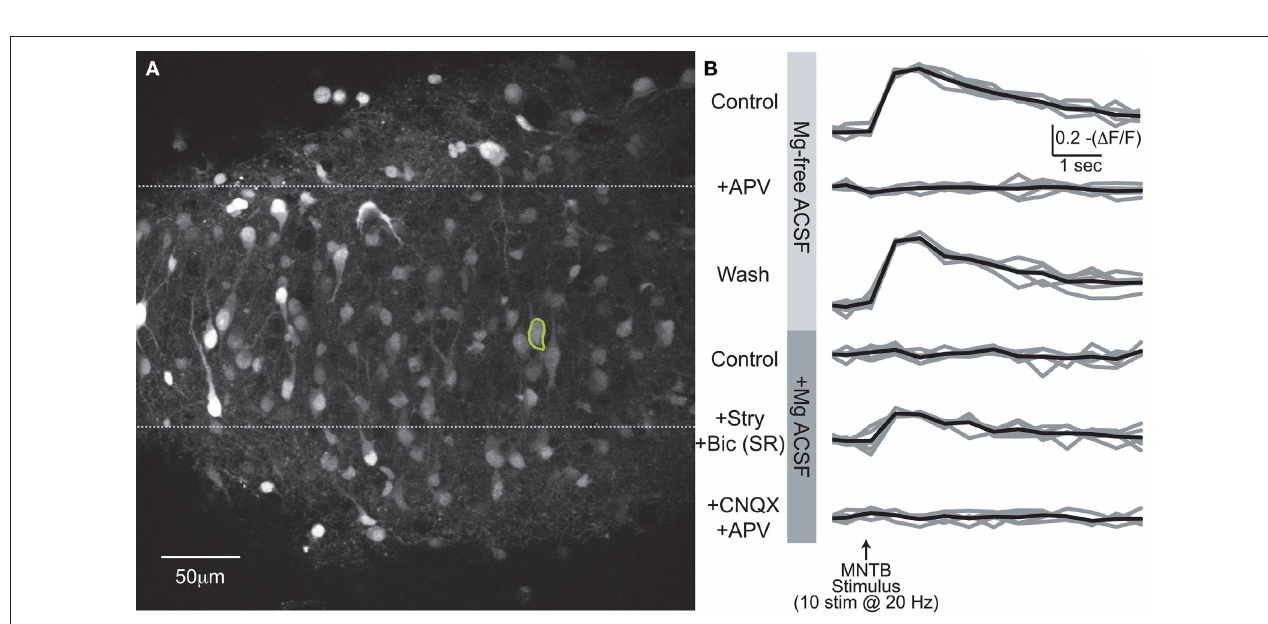
FiGUre 5 | Somatically recorded synaptic potentials are not affected by APV: (A–C) effect of APV on decay time determined by calculating the unit area of the last PSP (B) and comparing the time to reach 0.7 unit area in control and drug conditions (C). (D–F) Peaks of first (D) and last (e) PSPs and integral of last peak (F) are consistent throughout recordings.